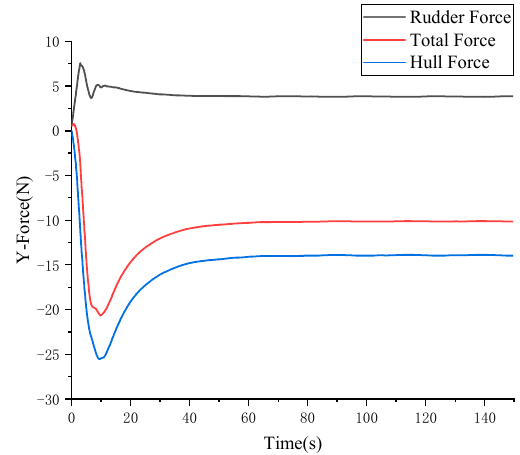
Figure 14. Force in +35 ◦ Y direction.